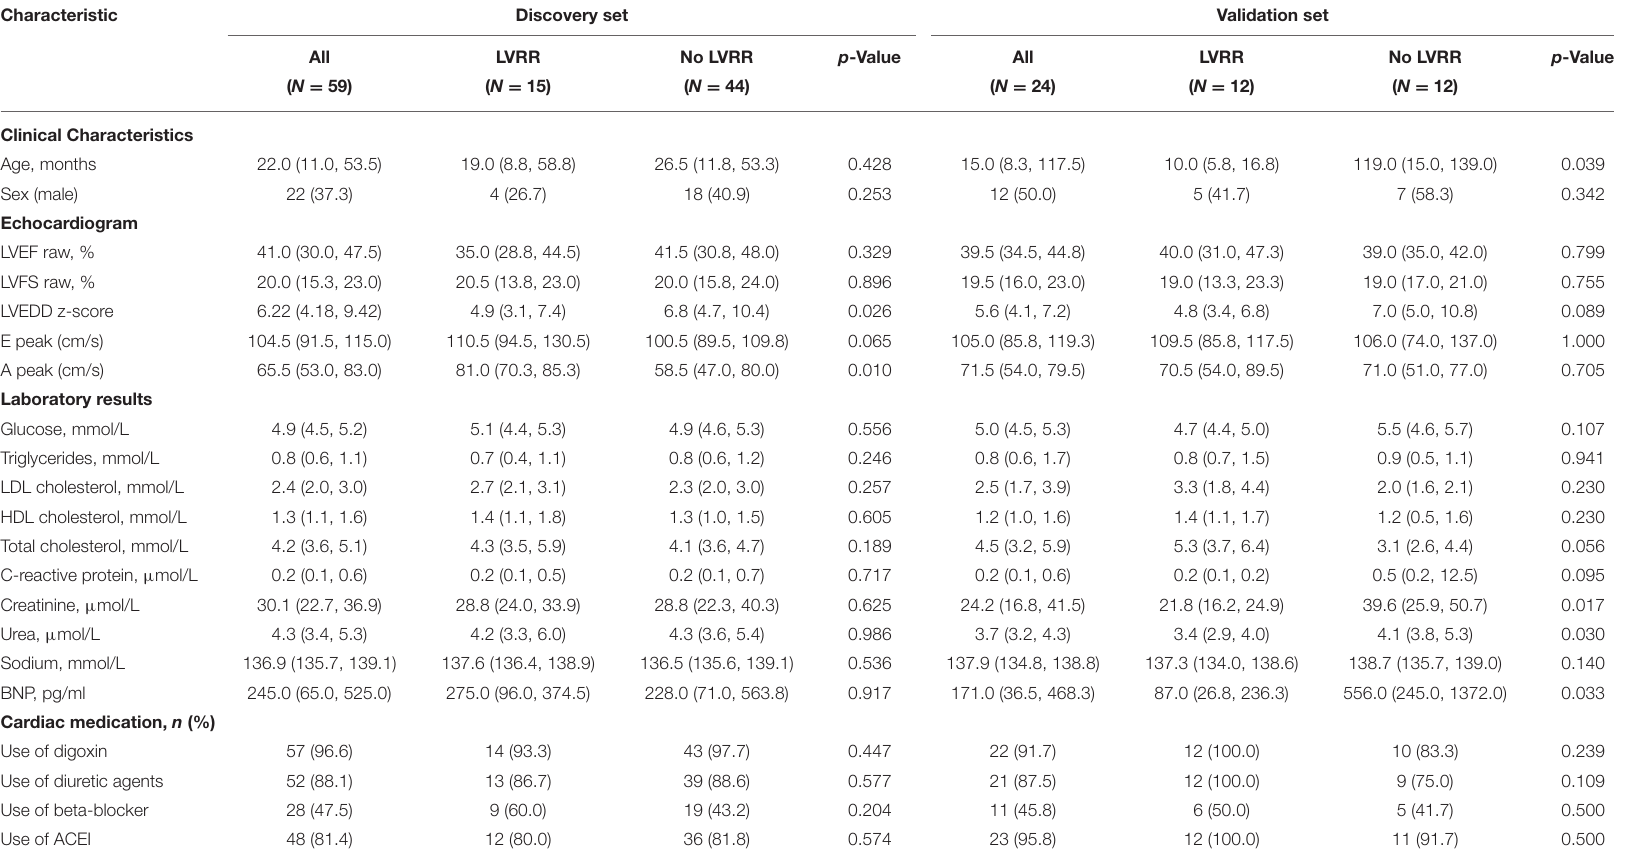
TABLE 1 | Baseline characteristics of pediatric dilated cardiomyopathy (PDCM) patients in the discovery set and validation set. Characteristic Discovery set Validation